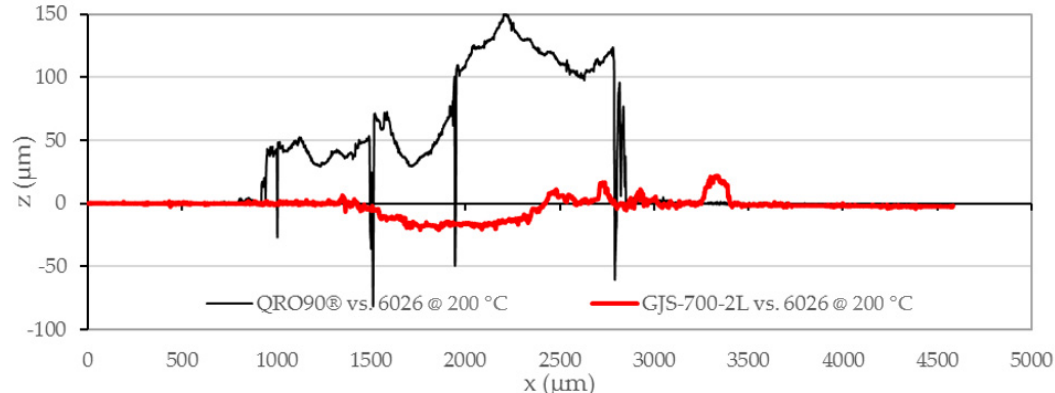
Figure 10. Depth profile of the track. Comparison of tool steel galling vs. cast iron wear when using 6026 pins in tests at 200 °C.